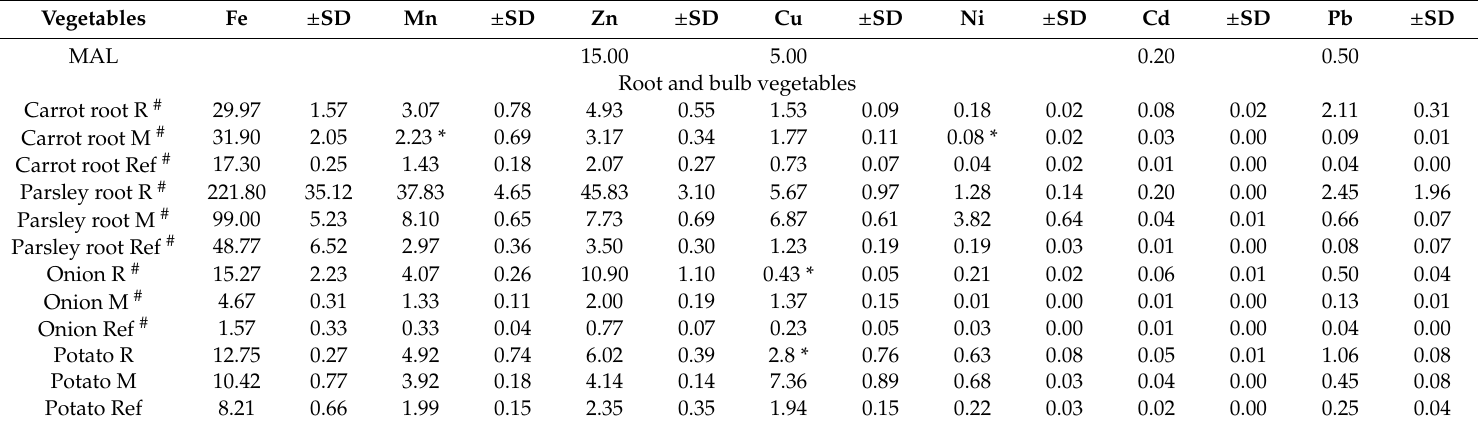
Table 3. Mean (and SD) for metal concentrations in analyzed root and bulb vegetables (mg / kg